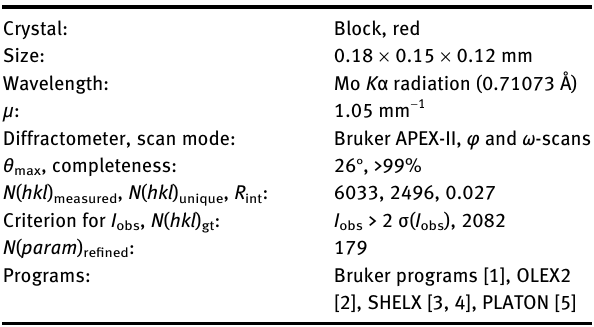
Table  : Data collection and handling. Crystal: Block, red